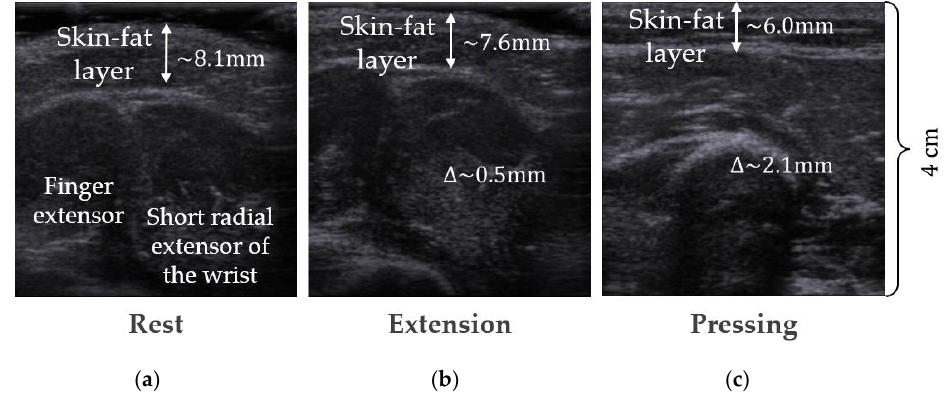
Figure 15. Example of transverse ultrasound images of internal structures of the forearm: ( a ) at rest; ( b ) when performing a wrist extension; ( c ) with an increase in the pressing force of the ultrasonic sensor to the skin surface.